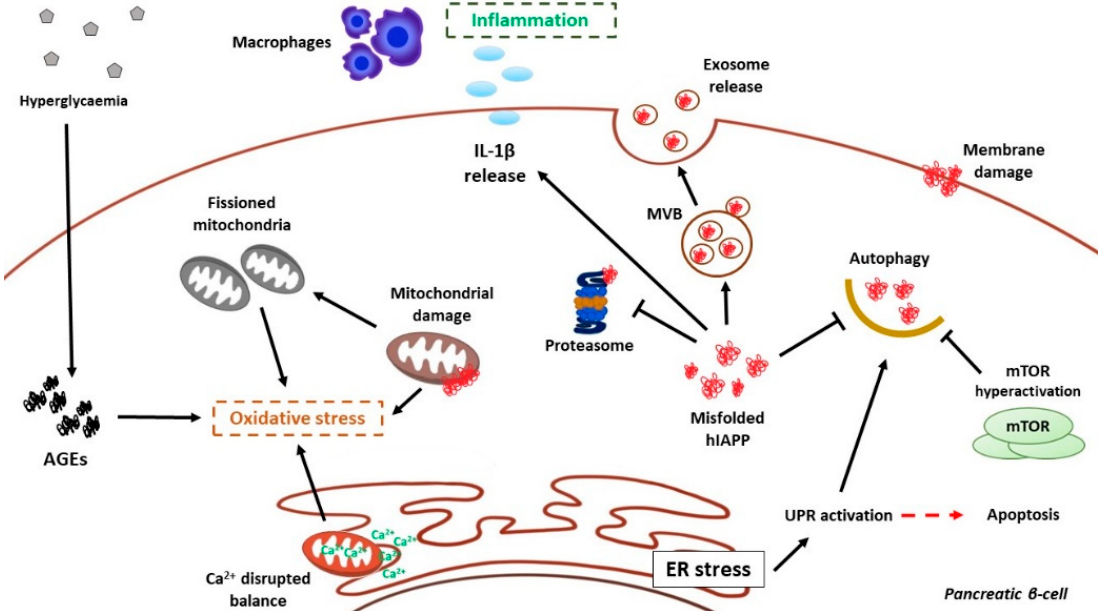
Figure 4. Hallmarks of pancreatic β cell failure in T2DM. Insulin secretory burden drives ER stress and misfolding of hIAPP. ER stress induces UPR activation in order to counteract protein aggregation, but chronic UPR activation leads pancreatic β -cell to apoptosis. ER stress could also promote Ca 2+ unbalance among ER-mitochondria, increasing ROS and oxidative stress. Autophagy is also activated by UPR for hIAPP aggregates elimination, and its failure could promote hIAPP accumulation and detoxification via MVB-exosome secretion; pancreatic β -cell mTOR hyperactivation (due to insulin resistance or hIAPP) in turn also impaired autophagy flux. In addition, hyperglycemia and hIAPP direct interaction are thought to inhibit proteasome aggregates clearance. hIAPP mitochondrial damage could increase ROS production, oxidative stress, and accumulation of fissioned mitochondria. Hyperglycemia causes the formation of aberrant glycated molecules, the advanced glycation-end (AGEs), which increase oxidative stress. hIAPP aggregates could also induce NLRP3-induced inflammasome activation, IL-1 β release, and macrophage